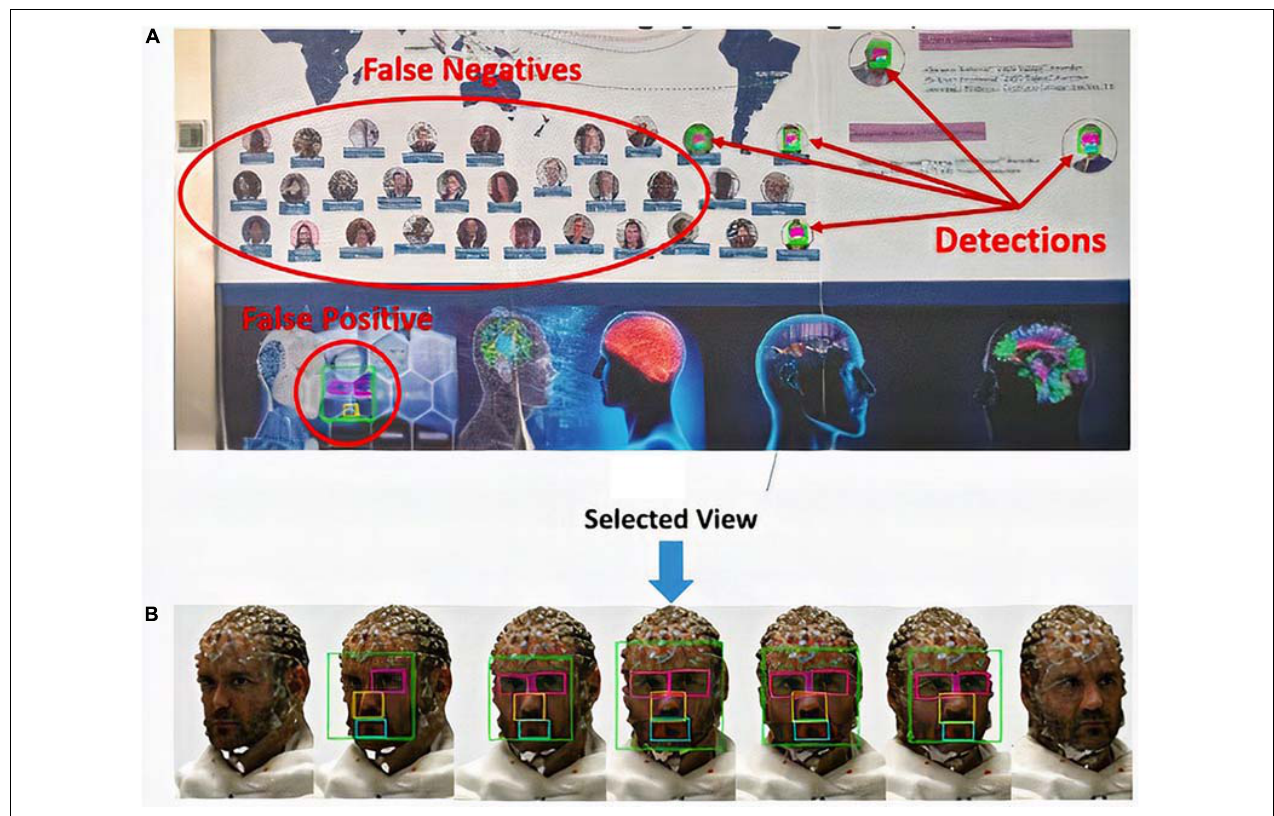
FIGURE 9 | Facial feature detection: (A) false-positive and false-negative result for the detection of facial features and (B) selection of the best view.